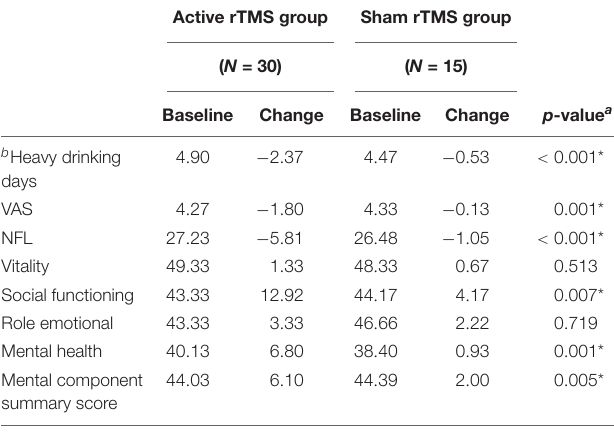
TABLE 3 | Changes in clinical outcomes for participants receiving active repetitive transcranial magnetic stimulation (rTMS) compared with those receiving sham